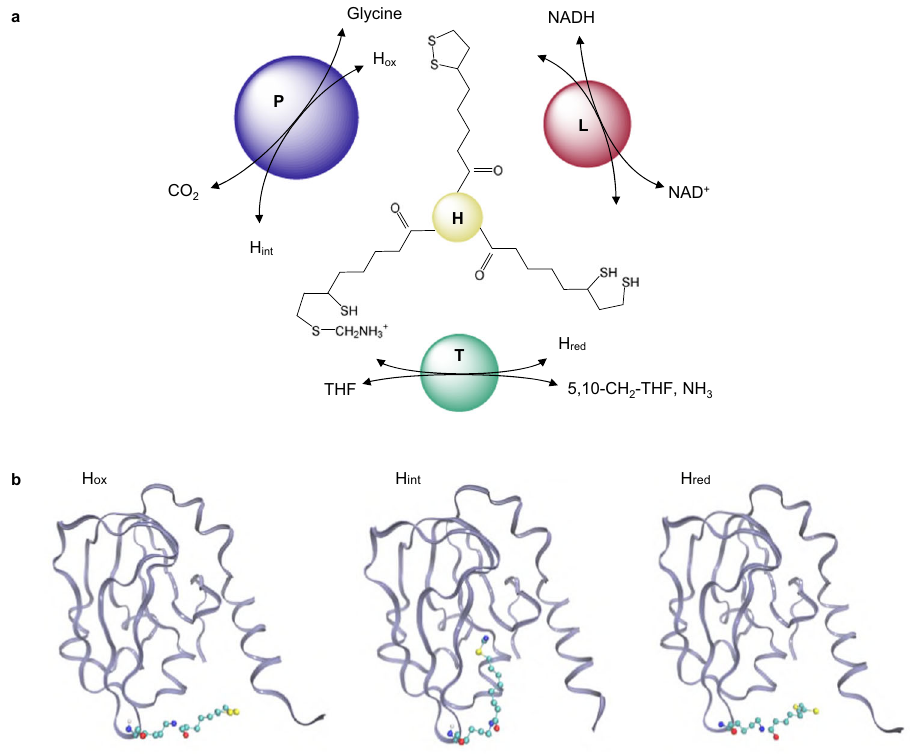
Fig. 1 Glycine cleavage system (GCS) and the three forms of protein H. a GCS showing the shuttle protein H and the molecules and reactions catalyzed by proteins P, T, and L, respectively. THF tetrahydrofolic acid, H ox an oxidized form of protein H, H int an intermediate form of protein H, H red reduced form of protein H. b Structures of the H ox , H int , and H red from Pisum sativum 22